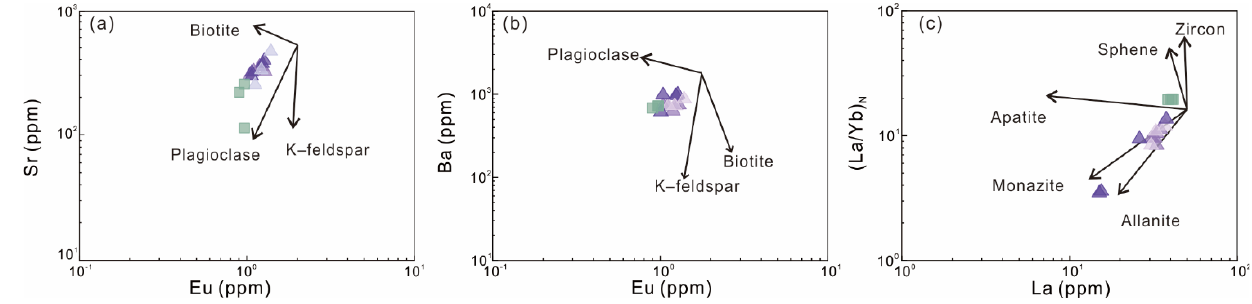
Figure 12. Plots of ( a ) Eu vs. Sr, ( b ) Eu vs. Ba, and ( c ) La vs. (La/Yb) N .